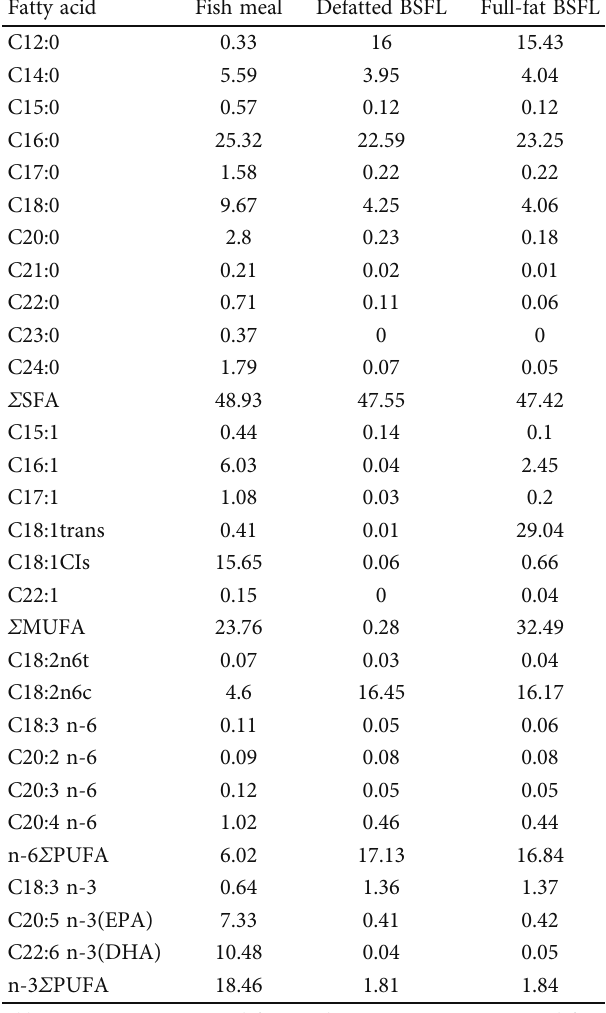
Table 1: Formulation and proximate composition of the experimental diets (% dry matter).